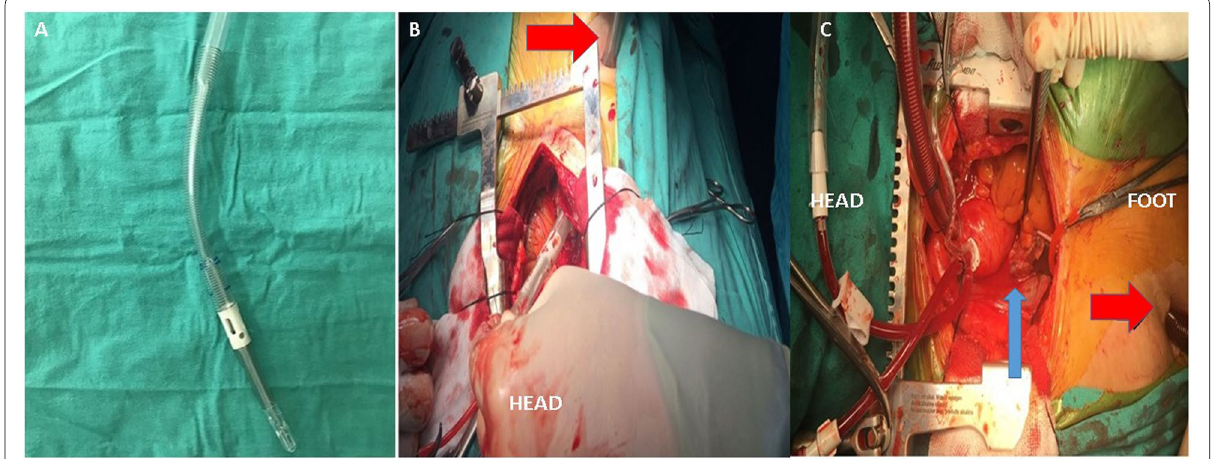
Fig. 1 A Medtronic MC2 ™ two-stage venous cannula (flat body or low profile body). B Venous cannula externalized from the chest. C The right atrial appendix was retracted; the aortic root exploration was achieved better (blue arrow). The red arrows show the exit point of the venous cannula from the right thoracic